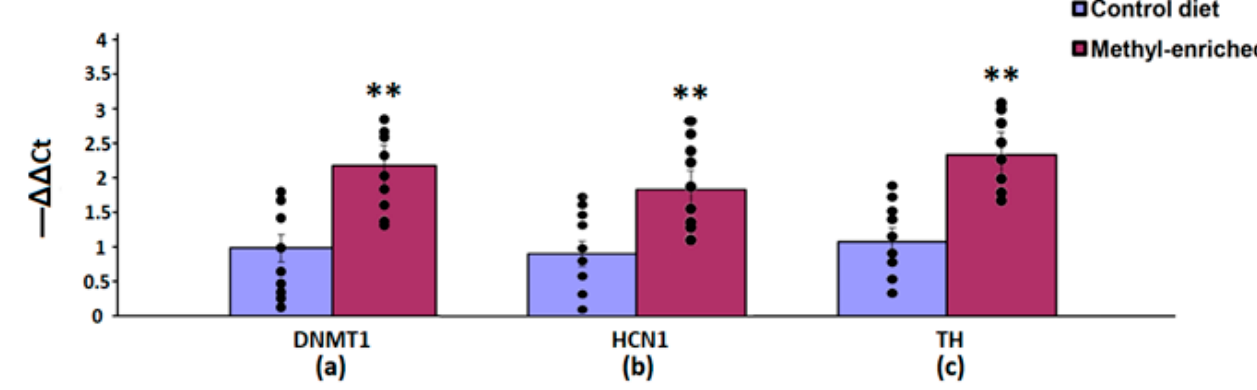
Figure 6. The mRNA expression levels of DNMT1 ( a ), HCN1 ( b ), and TH ( c ) genes in the nucleus accumbens in adult offspring of WAG/Rij rats born to mothers fed a methyl-enriched or control diet. Expression of the DNMT1, HCN1, and TH genes was determined by real-time qPCR in 9 pairs of tissue samples from the control ( n = 10 rats) and experimental ( n = 10 rats) group of animals. Data are the mean ± S.E.M. The individual data points are displayed in bar graphs to show within-group variability. **— p < 0.01 compared with the corresponding values in the control group.